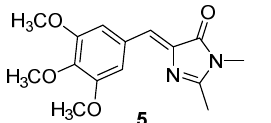
Figure 4. GFPc analogues presenting AIEE properties, combined with ACQ for some of them [16,17]. Figure 5. GFPc analogue emitting in the solid state, at different wavelengths depending on the pol- ymorph [19].